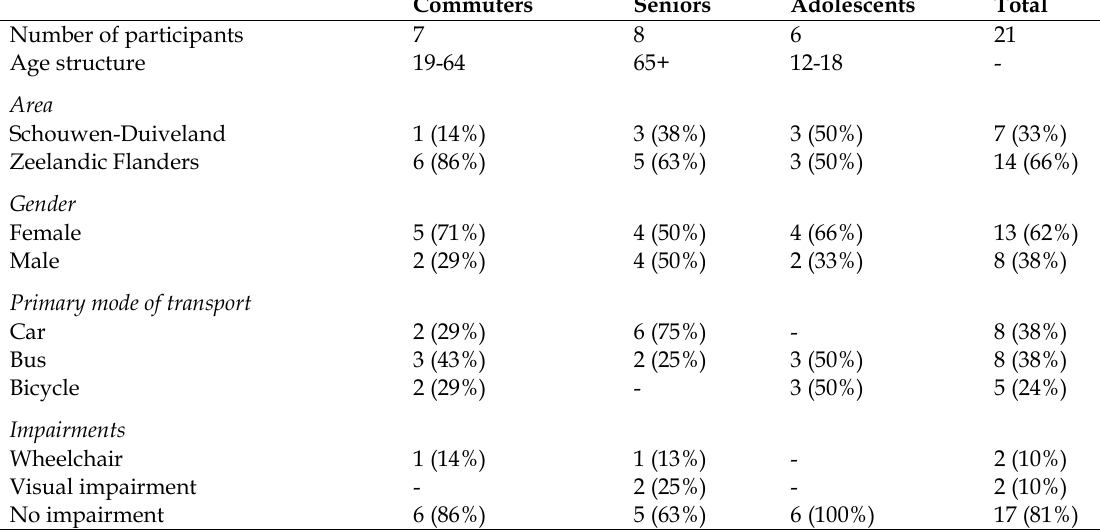
Table 1. Focus groups and their key